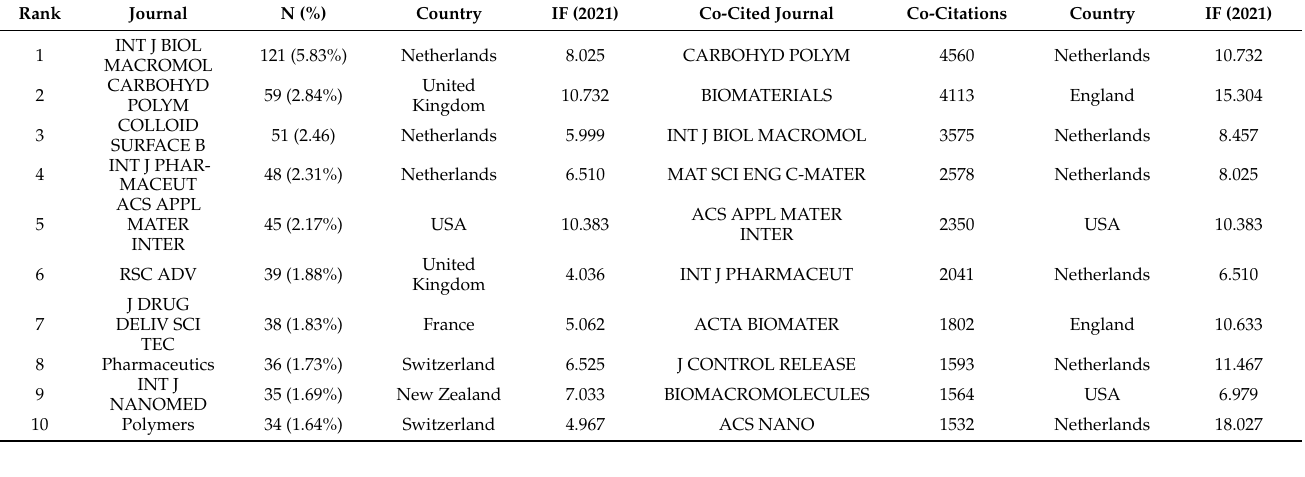
Table 1. The top 10 journals and co-cited journals of nano-drug release research in the wound healing field.